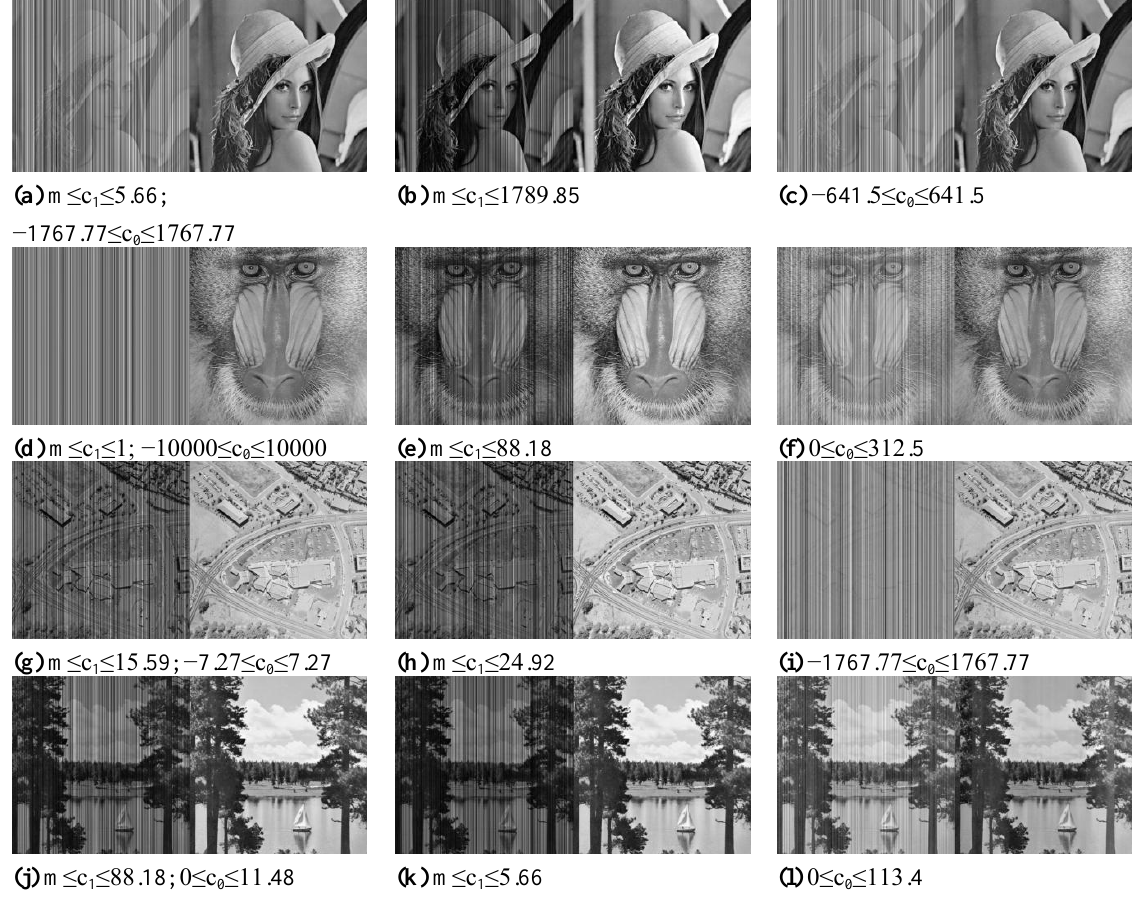
reductions (c,f,i,l); 0